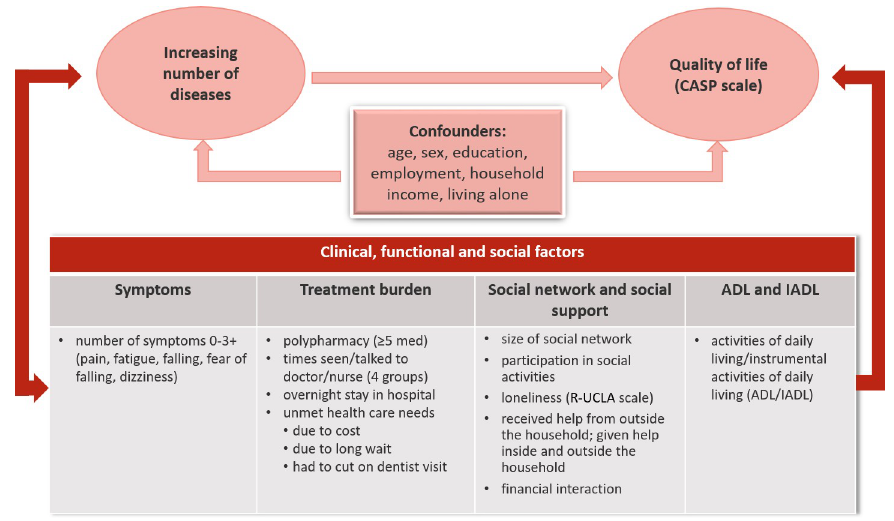
Fig 1. Conceptual framework describing clinical, functional and social factors to test for relevance in the association between number of diseases and quality of life adjusted for confounders.